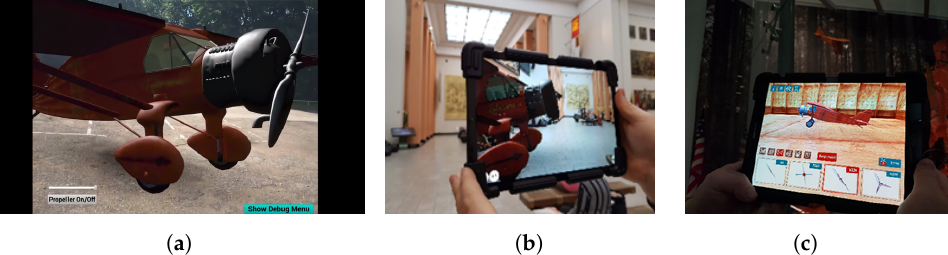
Figure 6. A 3D model of a historical aeroplane “Lituanica” in AR: ( a ) virtual aeroplane image, ( b ) a demonstration of augmented reality in real-life (museum) context, and ( c ) a screenshot of a